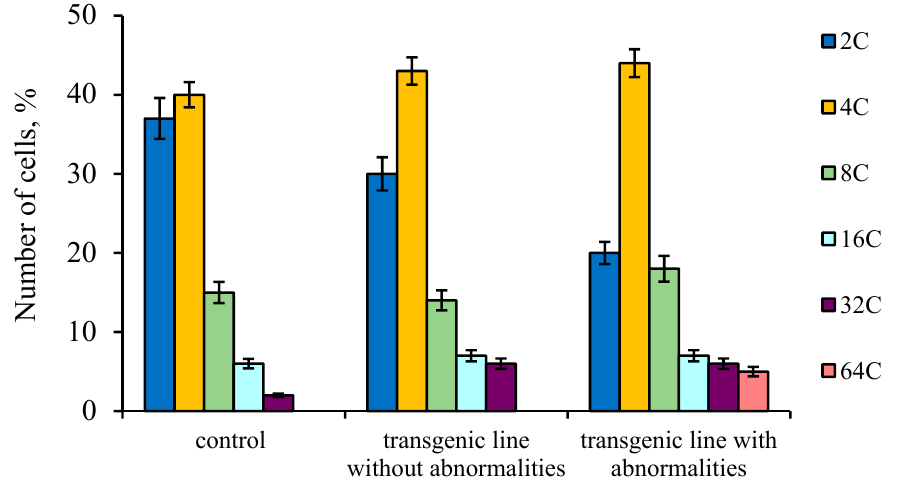
Figure 8. DNA content of isolated tapetal cells nuclei from control tomato anthers as well as transgenic tomato line without and with abnormalities. Data points are the means and their standard errors ( α = 0.05).